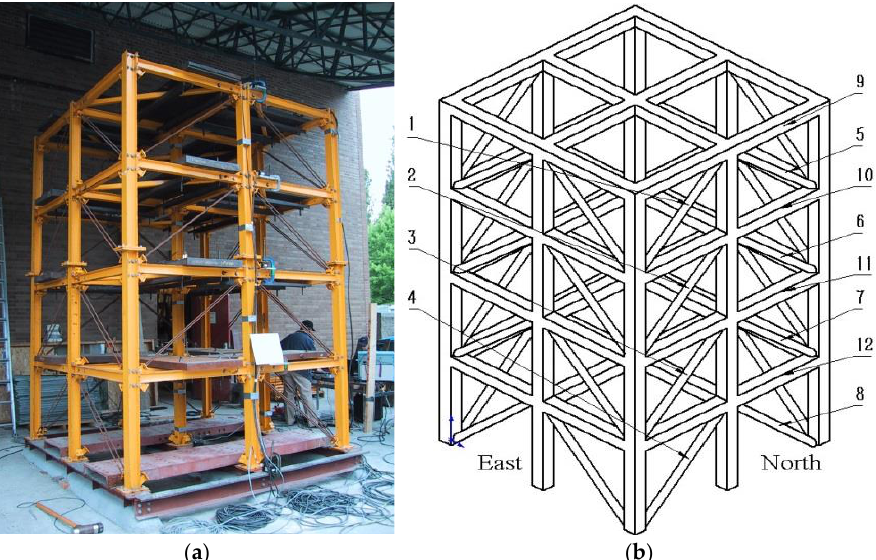
Figure 1. Building frame structure model. ( a ) Picture of frame structure, ( b ) 3D model of frame structure.